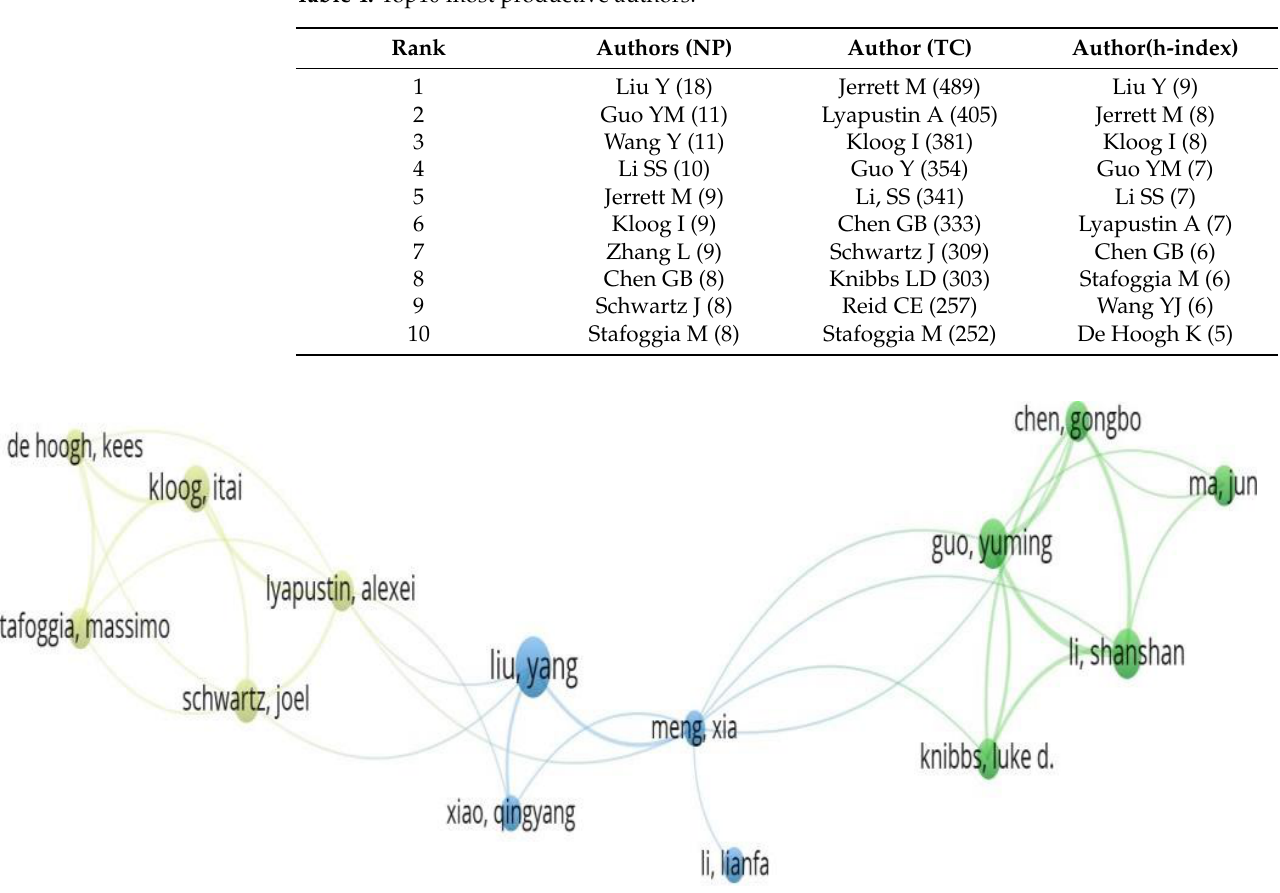
Table 4. Top10 most productive authors.